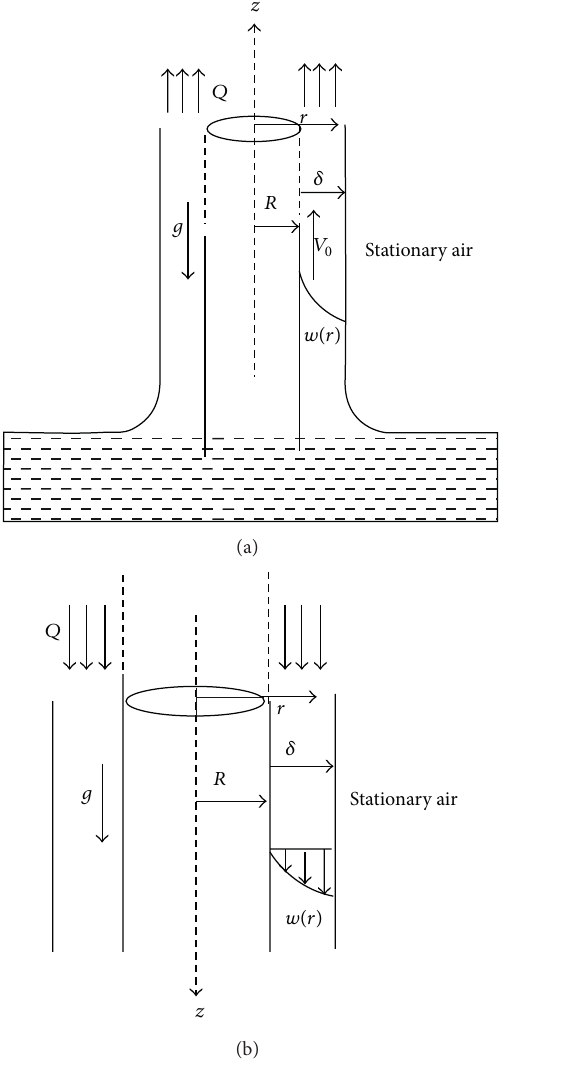
Figure 1: Geometry of the